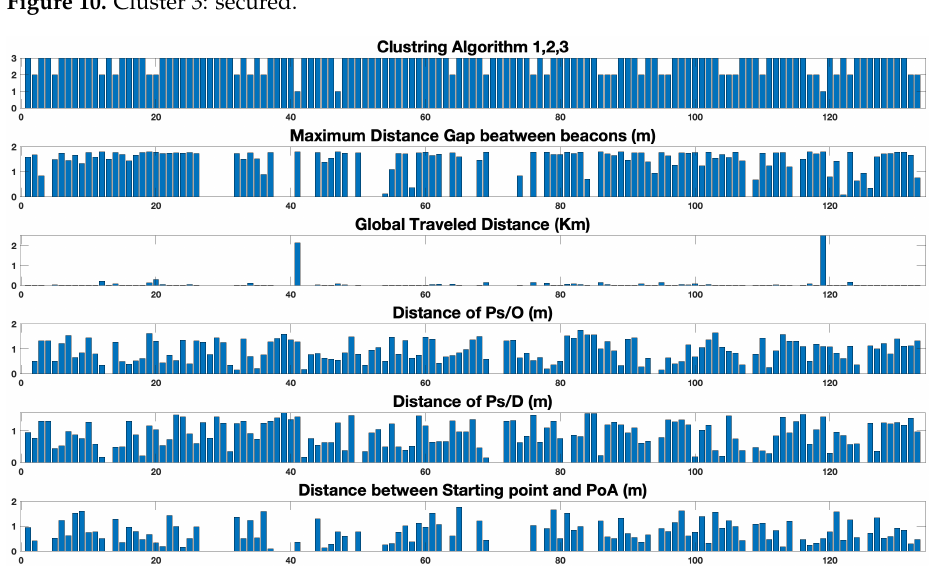
Figure 11. Clustering indication based on vehicle’s journey